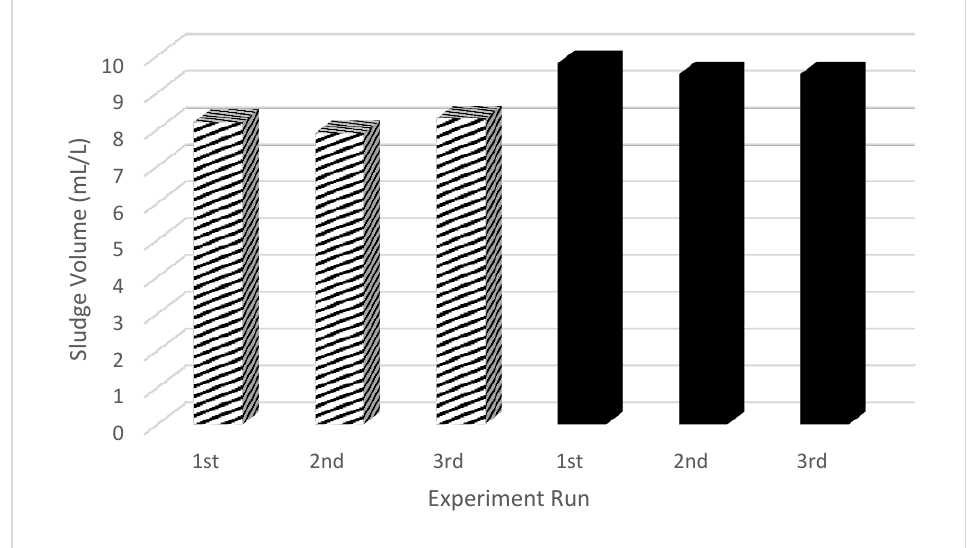
Figure 6. Volume of sludge produced after the treatment process.